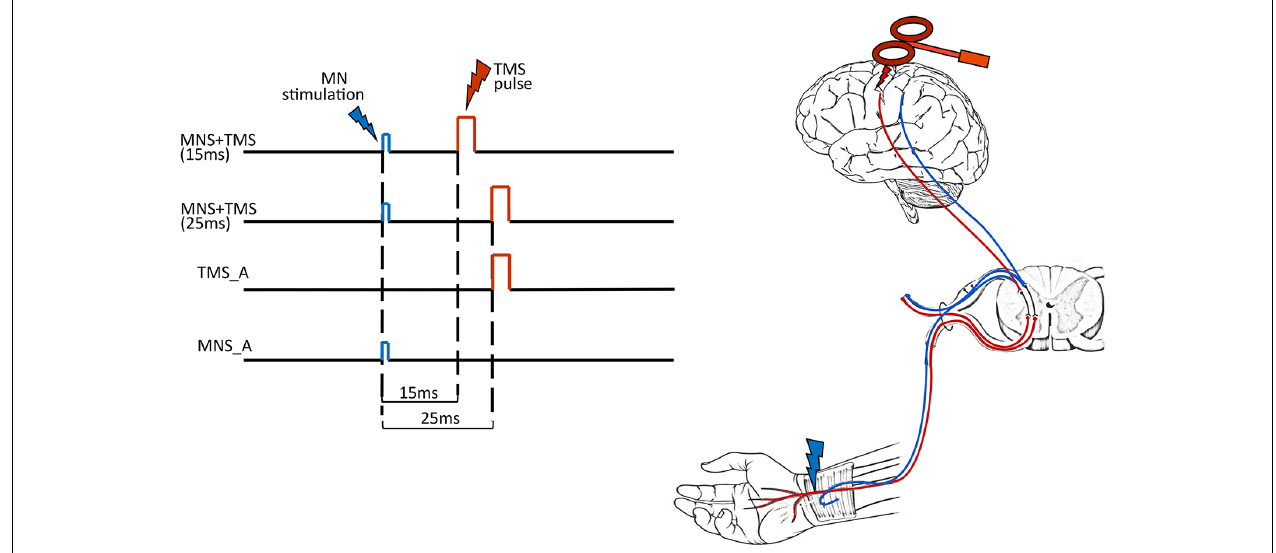
FIGURE 1 | Experimental conditions. In the left panel, each row represents the timeline of each experimental condition: MNS + TMS (15 ms), MNS + TMS (25 ms), TMS alone (TMS_A) and MNS alone (MNS_A). The right panel illustrates the two types of stimulation used in the study [median nerve stimulation (MNS) in blue and transcranial magnetic stimulation (TMS) in